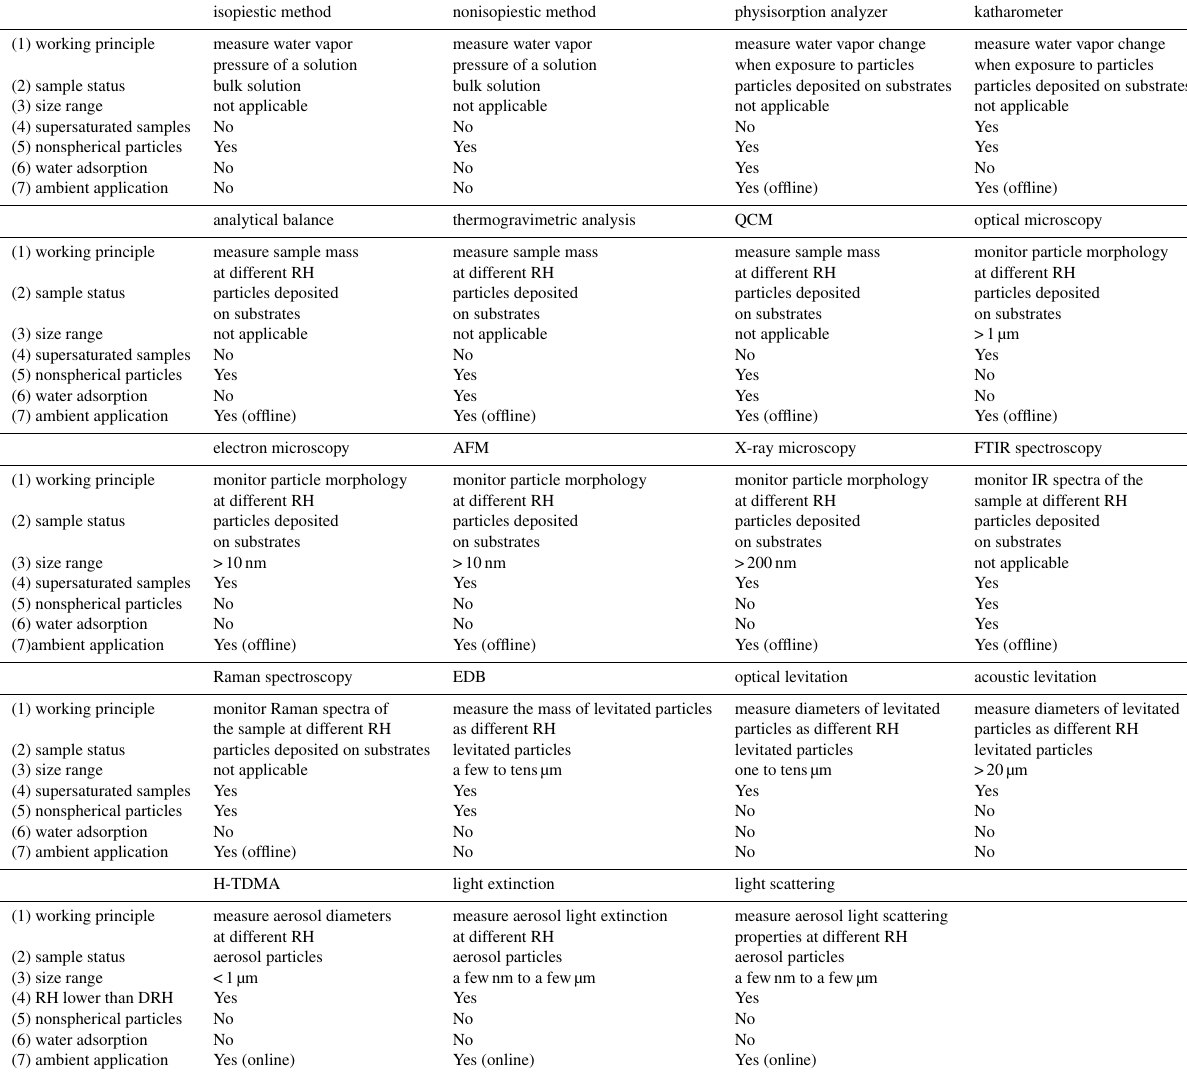
Table 1. Summary and comparison of key features of major techniques for aerosol hygroscopicity measurements. Please refer to Sect. 6 for further